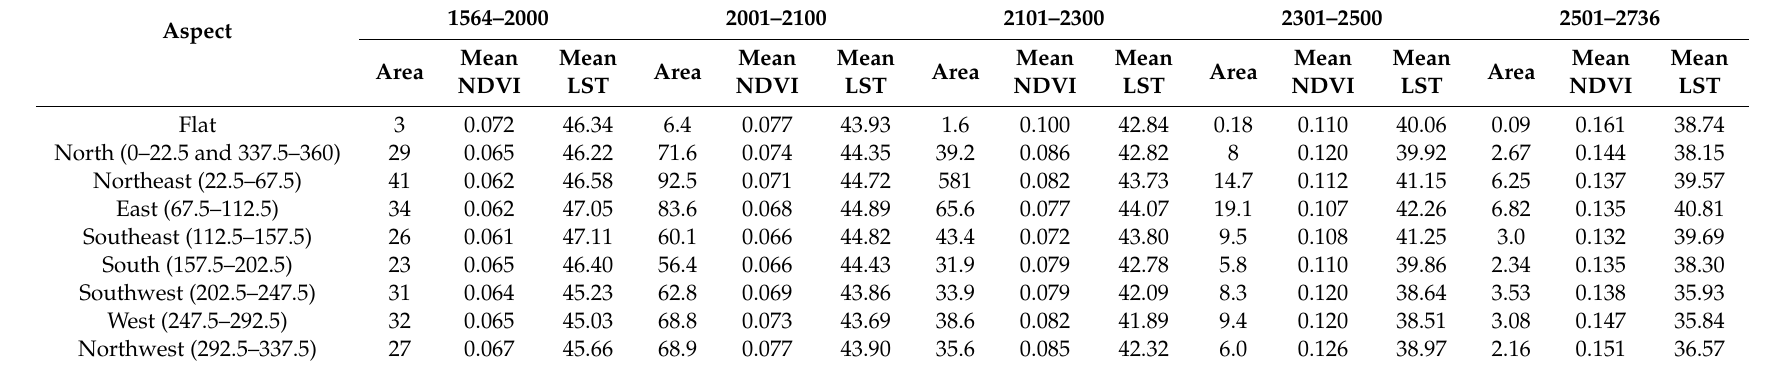
Table 4. Statistical analysis LST and NDVI over the aspect classes at the classified elevation